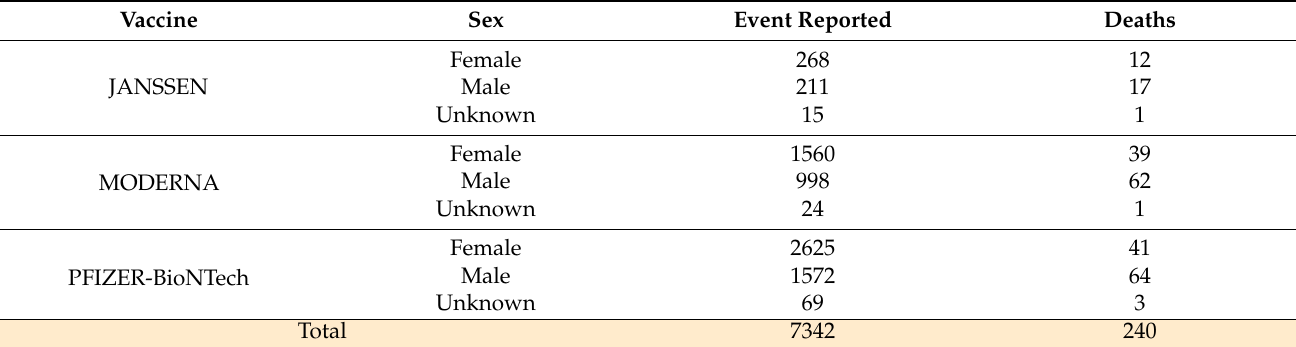
Table 2. Incidence and death from diabetes post-COVID-19